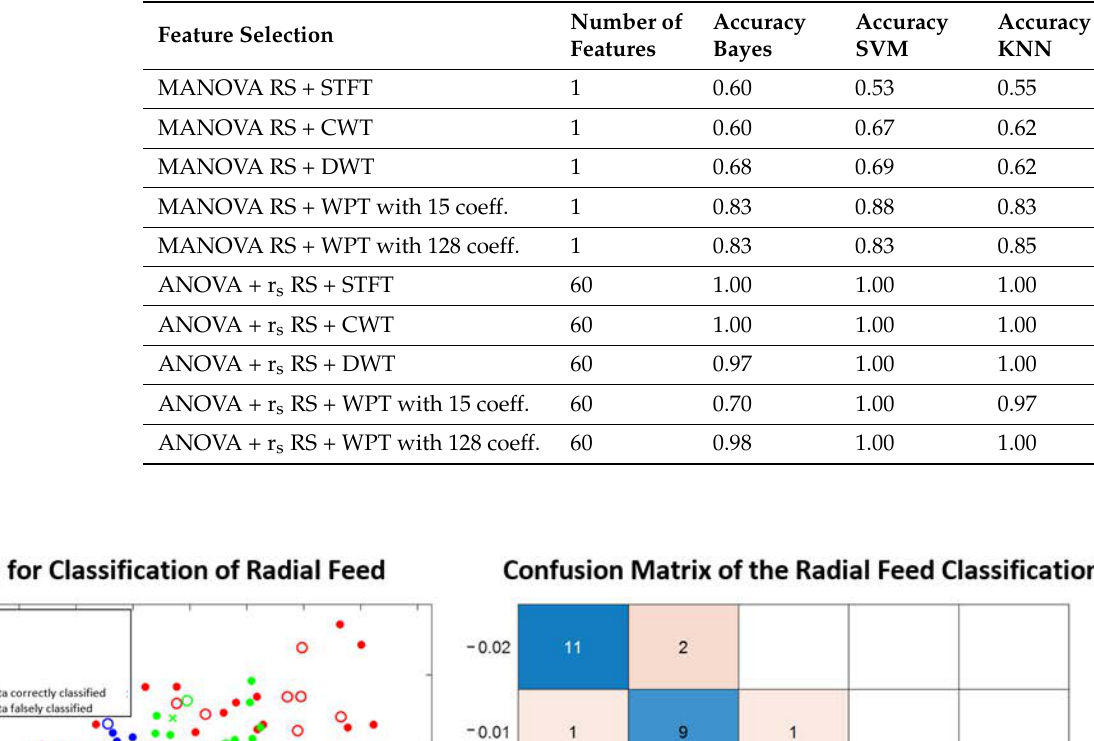
Table 5. Evaluations of the classification models for the classification of radial feed.